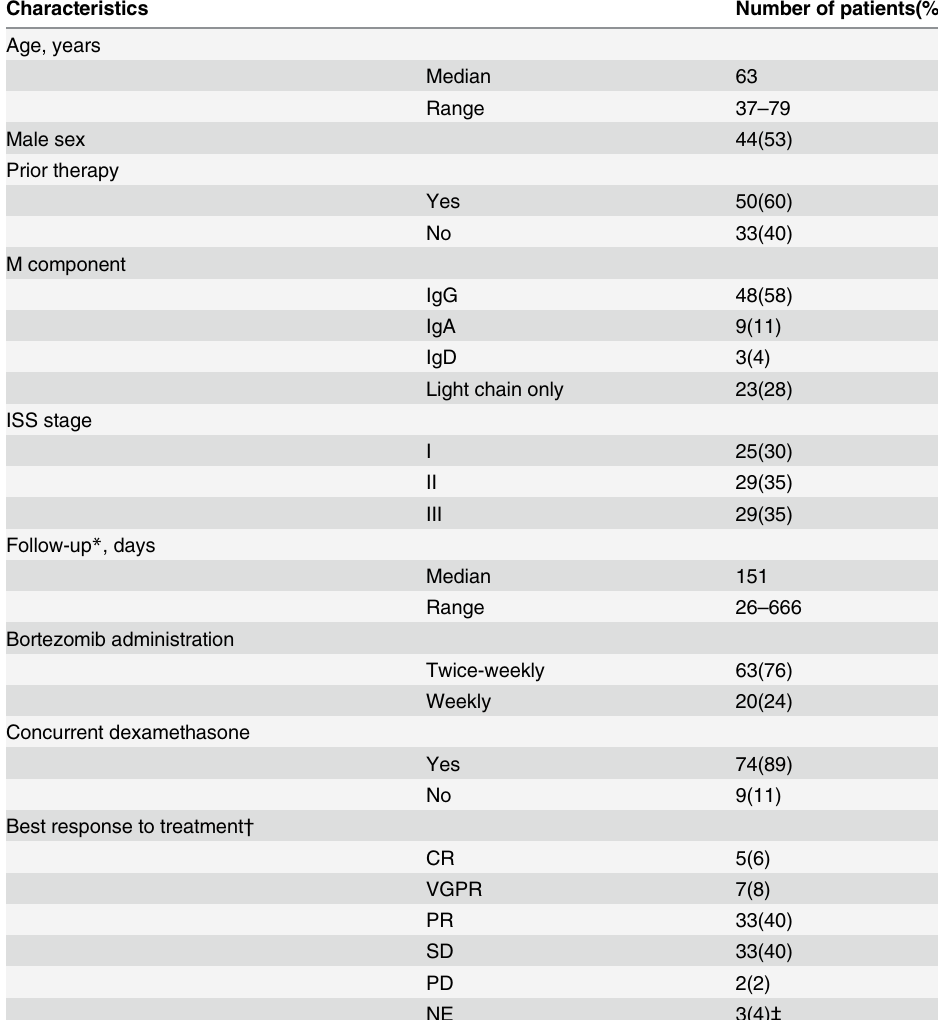
Table 1. Patients Demographic and Baseline